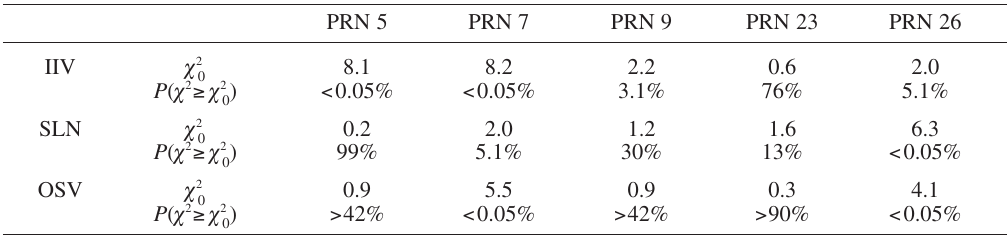
Table IV. The obtained reduced χ 2 ≥ χ 2 )) for each satellite-receiver pair, if we assume that measurements have a Gaussian 0